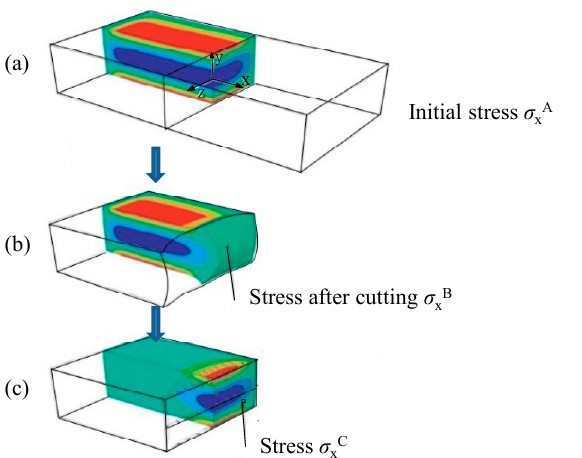
Figure 4. Principle of contour method: ( a ) Initial stress before cutting; ( b ) Stress after cutting; ( c ) Calculation of the initial stress.